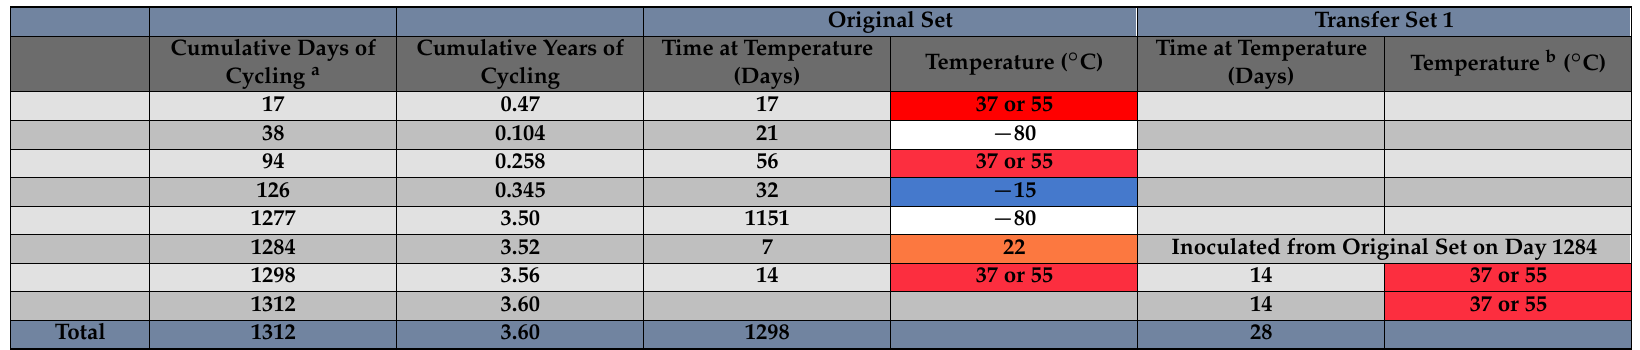
Table 5. Time intervals and temperatures for freeze/thaw cycling for Experiment